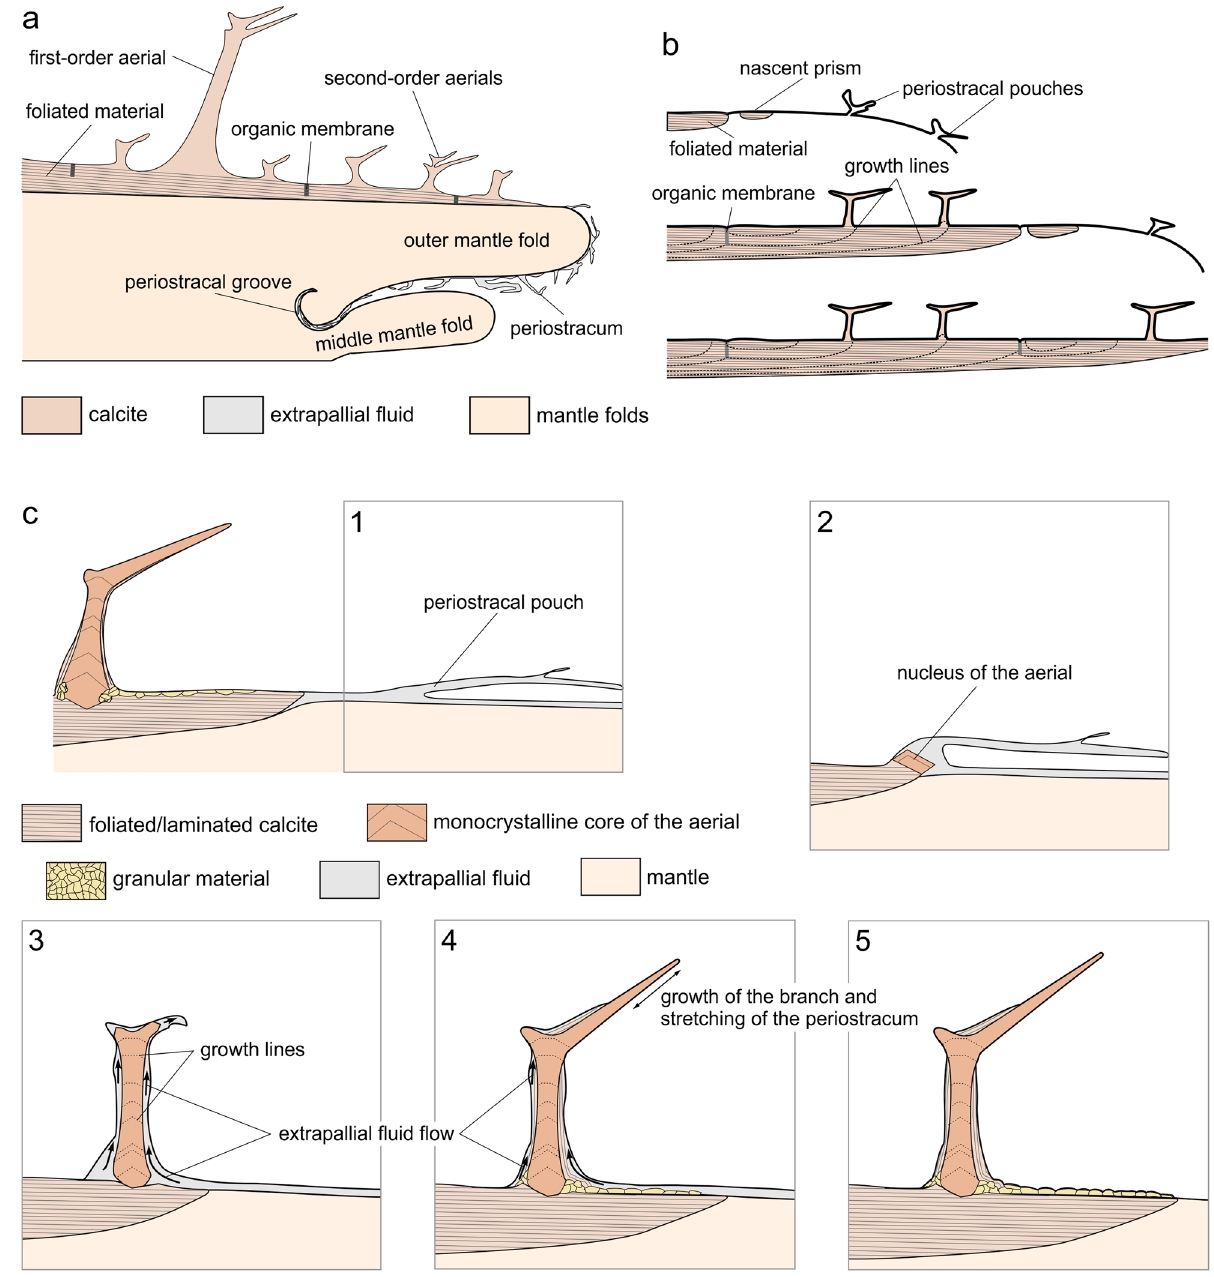
Figure 8. Model for the shell and aerial production by Catillopecten . ( a ) General scheme for the shell formation. The heavily folded periostracum is secreted within the periostracal groove and slides along the internal surface of the outer mantle fold. At the tip of the outer mantle fold, the periostracum is reflected toward the dorsum, and shell calcification begins, with the production of the outer prismatic layer. In the direction to the dorsum (to the left) aerials are produced in sequence on top of the shell, whereas a purely foliated layer is secreted below the prismatic layer. ( b ) Sequence of events (from top to bottom) for the production of prisms. Prisms initiate separated from each other. Upon meeting, they are initially separated by an organic membrane that later disappears in the direction toward the shell interior. ( c ) Stages (from 1 to 5) in the formation of the aerials. (1) Sliding of the periostracal pouch along the mantle surface. (2) Arrival of the periostracal pouch to the mineralization front, and formation of the initial nucleus of the aerial by the mantle. (3) Growth in height of the aerial when the mantle has abandoned the aerial production site. There is still supply of extrapallial fluid from the mantle in the passageway between the shell surface and the periostracum. (4) Aerial growth is almost complete, and production of laminated and granular deposits takes place at the voids between the periostracum and the monocrystalline core of the aerial. Conversely, the periostracum becomes stretched at the most elevated parts of the aerials, particularly, the branches. (5) Growth of the aerial (tips of the branches) is completed, as well as the production of laminated and granular deposits. The periostracum adheres to the surface of the